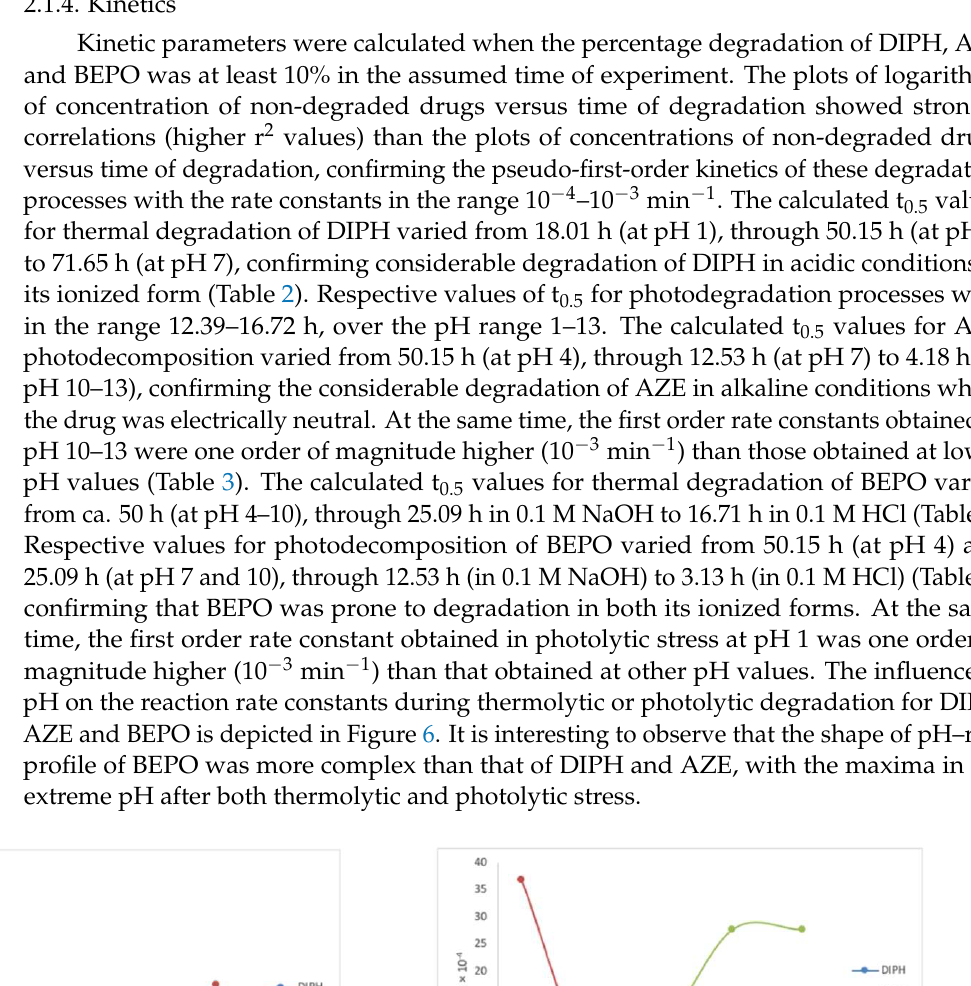
( C ) Figure 7 . Typical chromatograms of the stressed drugs: ( A ) diphenhydramine (DIPH) after stressing with temperature in 0.1 M HCl (DIPH = 5.894 min, D1 = 0.935 min, D2 = 1.893 min, D3 = 4.509 min and D4 = 7.120 min); ( B ) azelastine (AZE) after stressing with UV/VIS light at pH 10 (AZE = 3.054